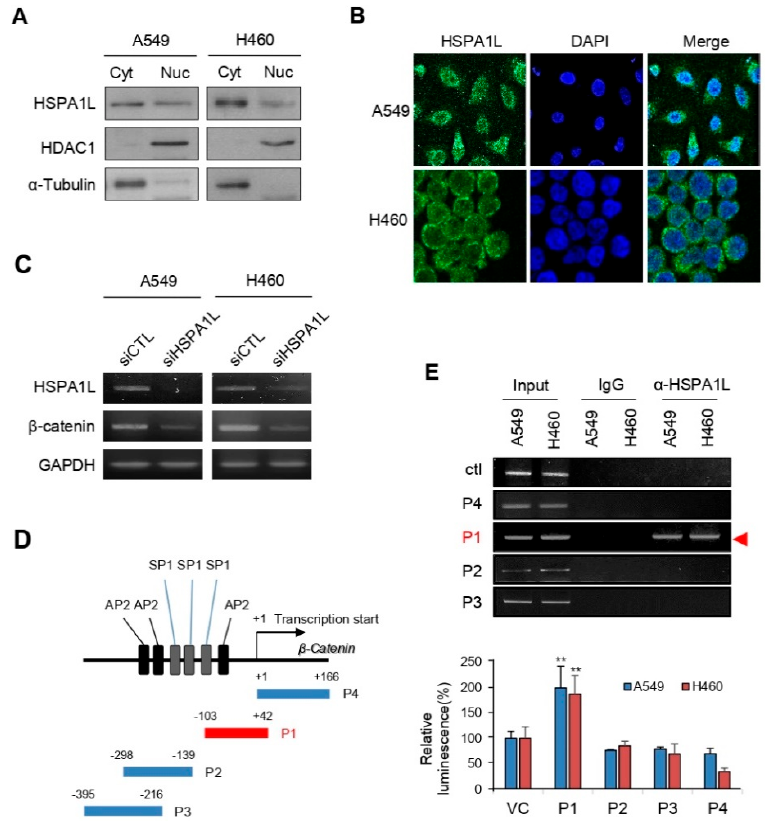
Figure 5. HSPA1L directly binds to a specific β -catenin promoter region and regulates β -catenin gene expression. ( A ) Different subcellular fractions of A549 and H460 cells were prepared; Cyt: cytosolic fraction; Nuc: nuclear fraction. Western blot analysis indicated that HSPA1L was localized in both the cytoplasm and the nucleus. ( B ) Immunocytochemistry analysis of HSPA1L localization; HSPA1L localized in both the cytoplasm and the nucleus in A549 and H460 cells. ( C ) HSPA1L regulated β -catenin gene expression. ( D ) Nucleotide sequence of the 5 (cid:48) -flanking region and noncoding exon 1. Schematic diagrams of the potential promoter regions of the β -catenin gene. ( E ) ChIP analysis of HSPA1L binding to potential promoter regions of β -catenin in A549 and H460 cells. RT-PCR was performed using primers specific to the promoter region. Luciferase activities were measured after transfecting the promoter construct in A549 and H460 cells. Data represent the mean ± SD of three independent experiments using a two-tailed t-test. ** p <